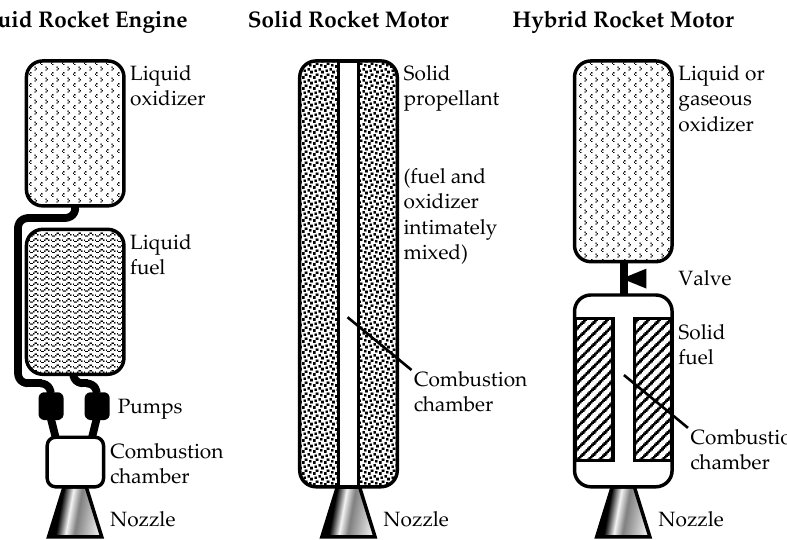
Figure 1. Schematic example of each of the 3 types of chemical rocket propulsion systems.